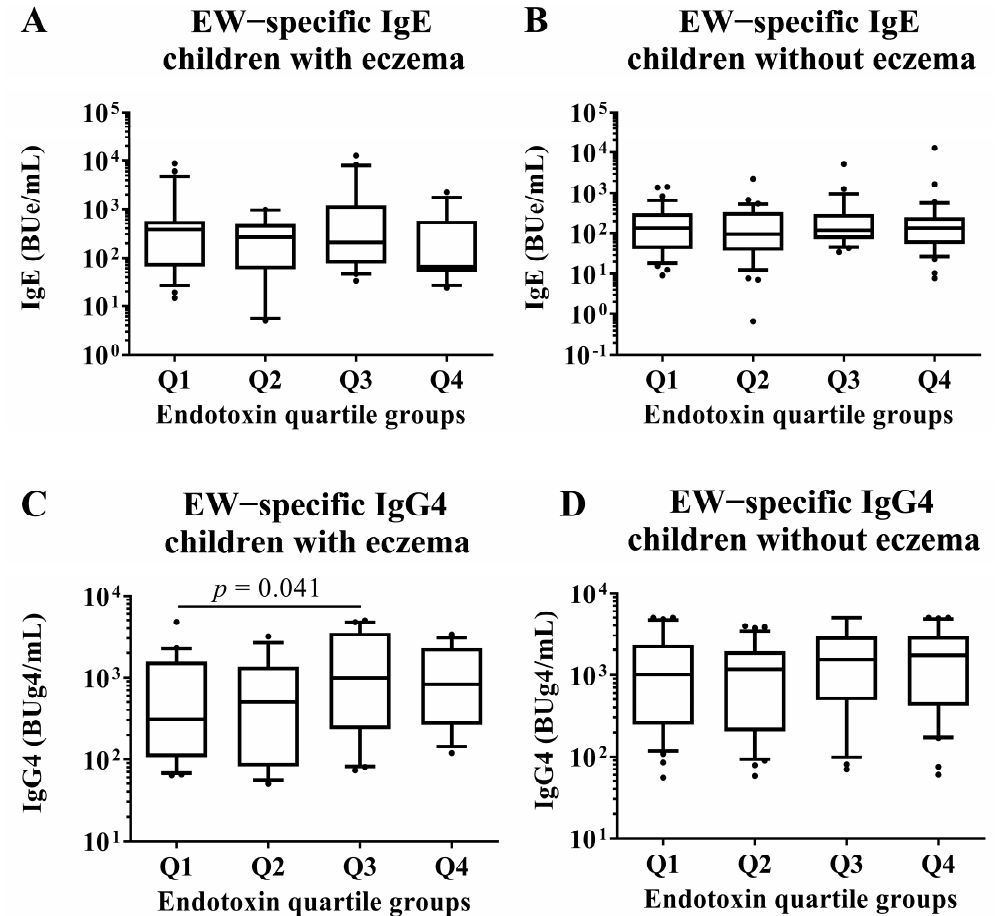
Figure 6. Subgroup analyses by the presence of eczema in children who had HE allergy in their first year of life. Comparison of EW-specific IgE and IgG4 levels in sera of children at 2 years old among quartile groups of endotoxin concentration (Q1–Q4) per 1 g of house dust collected from the mattresses of the children at 18 months old. These show results in ( A ) EW − specific IgE level in children with eczema, ( B ) EW − specific IgE level in children without eczema, ( C ) EW − specific IgG4 level in children with eczema and ( D ) EW − specific IgE level in children without eczema. p -values were calculated for each log-converted Ig level using Mann–Whitney U test based on Q1. p -values < 0.05 were considered significant.